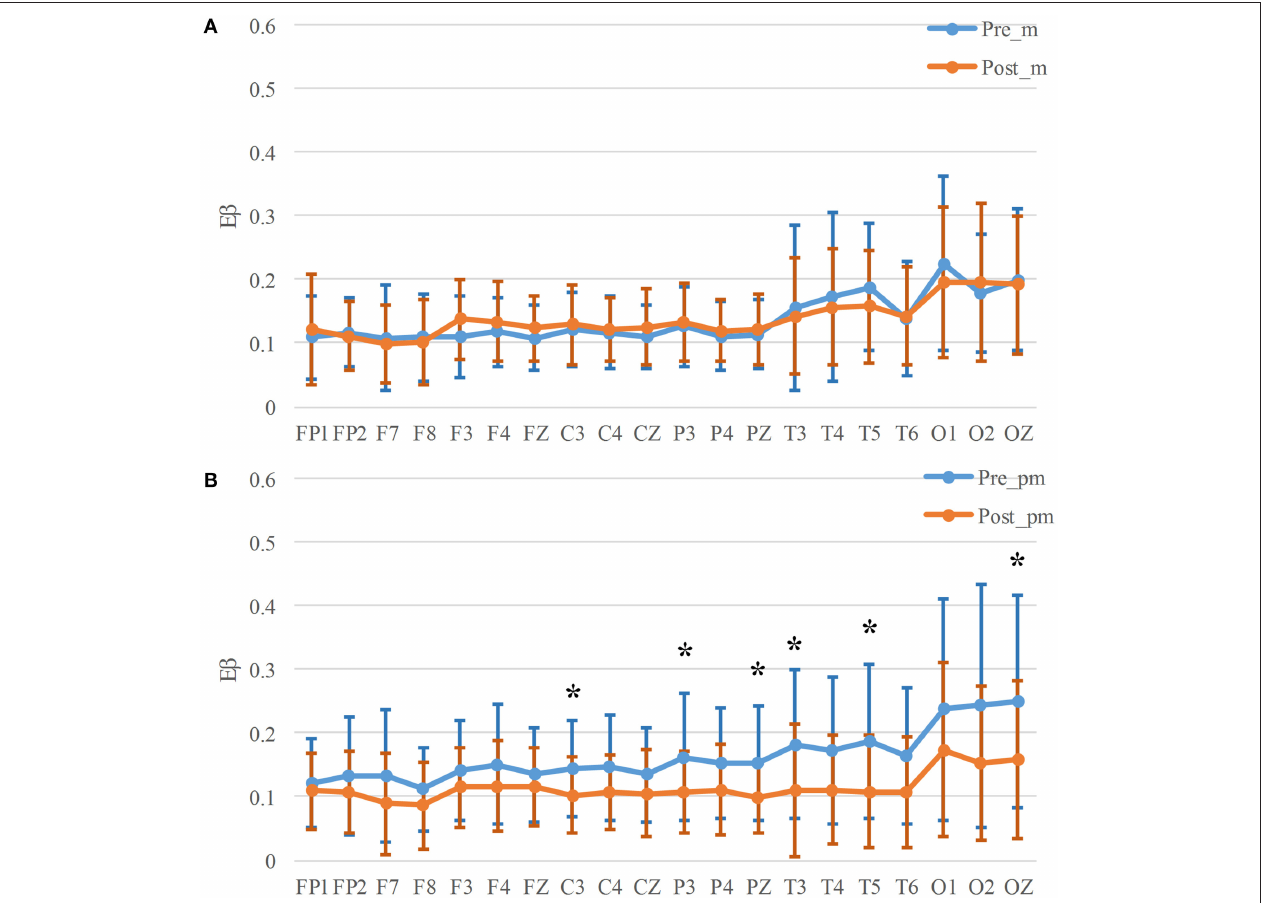
FIGURE 3 | E β for mental (A) and physical mental tasks (B) . * p < 0.05.